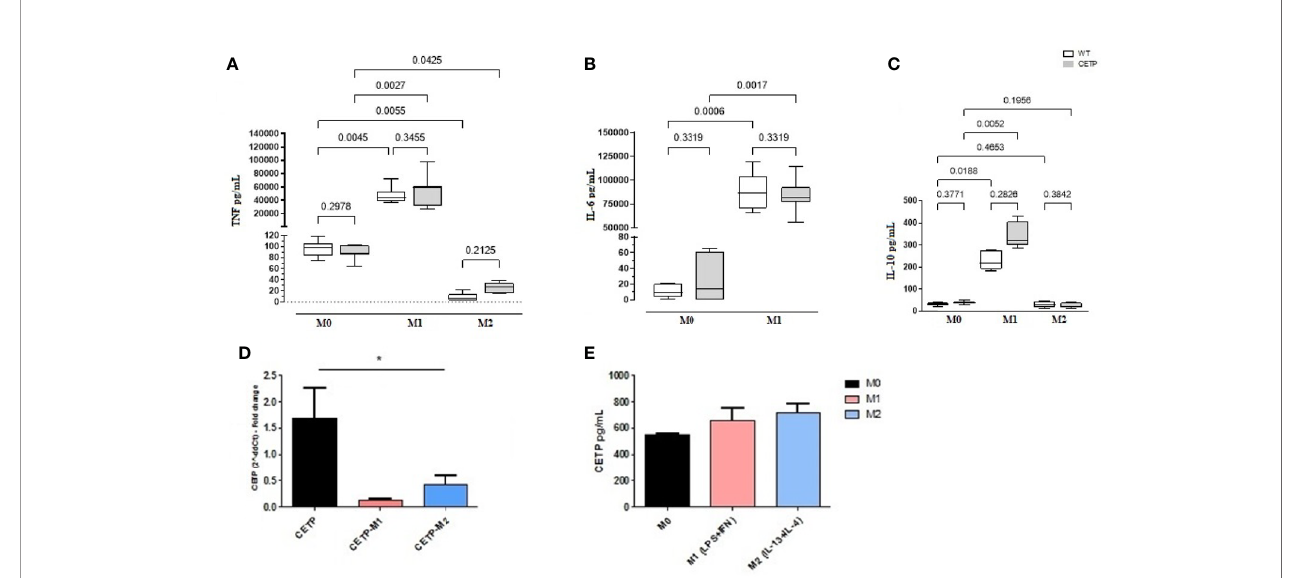
FIGURE 5 | Cytokine secretion, CETP expression, and secretion in cell culture medium. Bone marrow-derived macrophages from WT and huCETP mice, unpolarized (M0), or stimulated to M1 (5 ng/ml IFN g + 50 ng/ml LPS) or to M2 (10 ng/ml IL-13 + IL-4) for 24 h. TNF- a (A) , IL-6 (B) , IL-10 (C) , CETP mRNA expression in macrophages (D) and CETP secretion (E) . Concentrations were determined by ELISA, and CETP expression was determined by RT-PCR. Values expressed as median and percentiles 25 and 75 were analyzed by Kruskal – Wallis test with original FDR method of Benjamini and Hochberg post-test. Values were expressed as mean and standard deviation analyzed by ANOVA with two-stage linear step-up procedure of Benjamini, Krieger, and Yekutieli post-test; (n = 5 – 8). P < 0.05. *M0 vs . M1 and